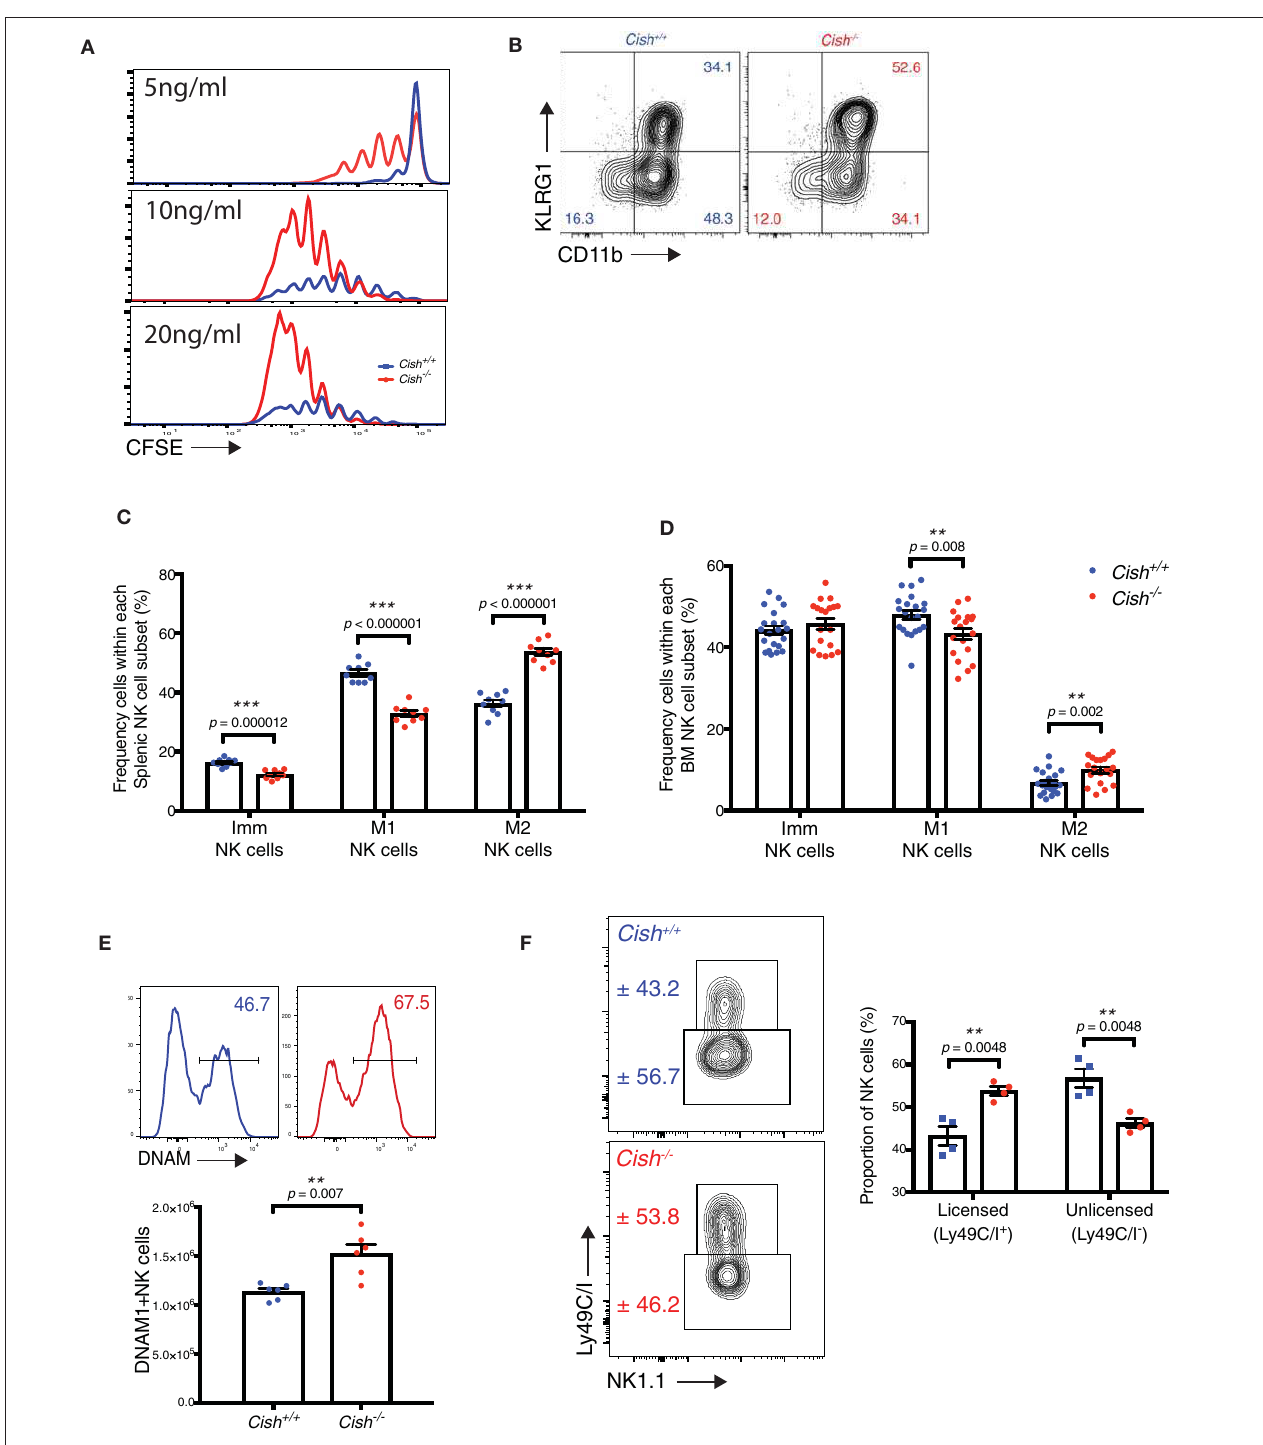
FIGURE 1 | CIS-deficient NK cells show increased maturation. (A) Purified and CTV-labeled Cish − / − and Cish + / + NK cells were seeded at 1 × 10 4 cells/well into round wells containing different concentrations of IL-15. Cells were incubated at 37 ◦ C in a humidified environment containing 5% CO 2 for 240h. Representative histogram overlays are shown. (B–D) NK cell maturation subsets were quantified by flow cytometric analysis of KLRG1 and CD11b in Cish + / + and Cish − / − mice. (B) Representative FACS plots showing the abundance of each maturation subset and gating strategy in the spleen. Frequency of Imm, M1, and M2 cells were measured within NK cell populations from the (C) spleen and (D) BM ** p < 0.01, *** p < 0.001 (unpaired Student’s t -test). (E,F) Flow cytometry was used to quantify DNAM-1 and Ly49C/I expression. Representative histograms of DNAM-1 expression ( E , top panel) and Ly49C/I expression ( F , left panel) and frequency of DNAM-1 + NK cells ( E , bottom panel), and licensed and unlicensed NK cells ( F , right panel) ** p < 0.01 (unpaired Student’s t -test). ( A,B , one representative of three experiments; C , n = 9 biological replicates mean ± s.e.m.; E , F , values indicate mean ± s.e.m. and n ≥ 4 biological